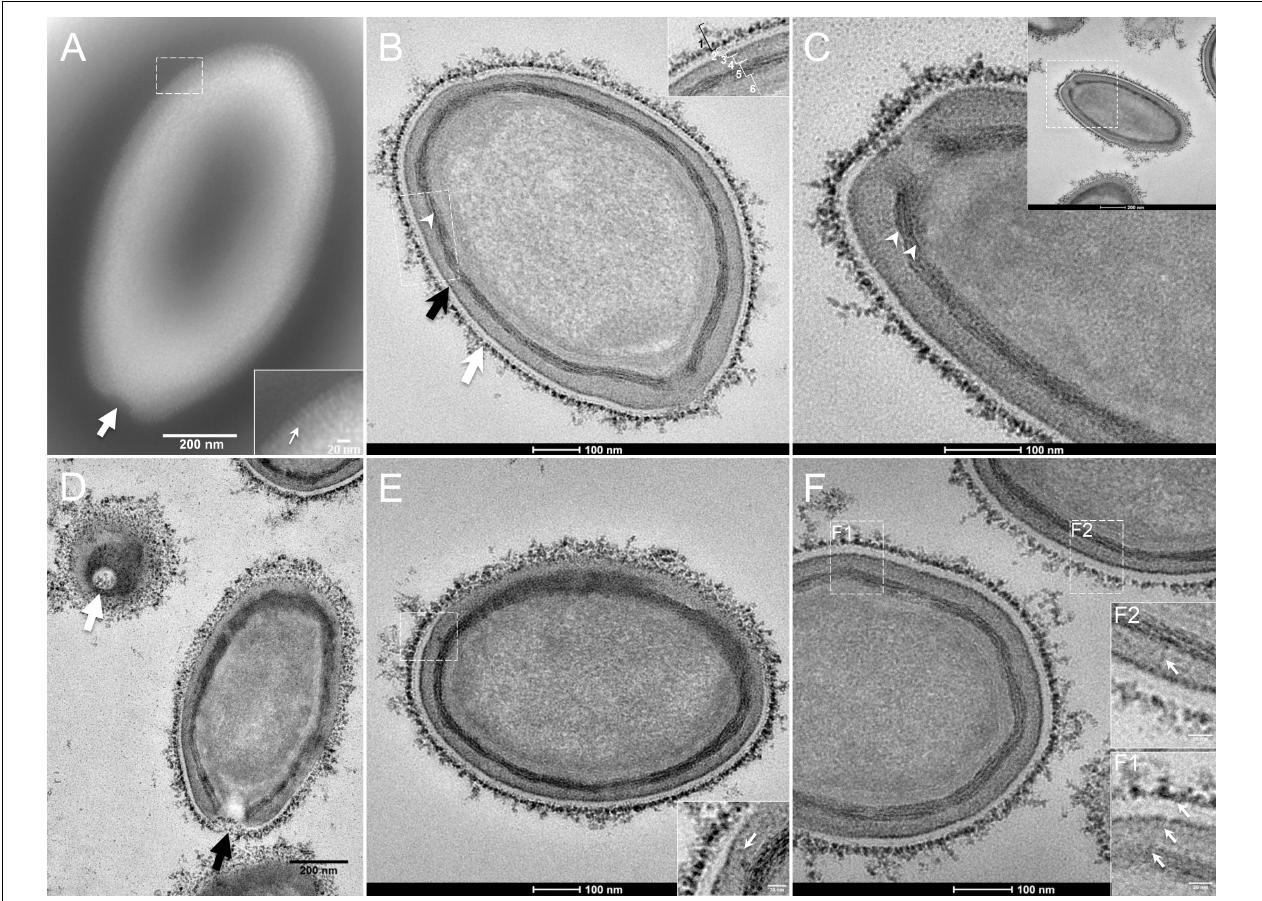
FIGURE 1 | Transmission electron microscopy (TEM) of Pandoravirus massiliensis . (A) Negative staining of a P. massiliensis particle: the ostiole (arrow) is located at the apex of the particle. Peripheral thin fibers can be observed enwrapping the particle (thin arrow in boxed zoomed region). (B) Ultrathin section showing (i) the most-peripheral sugars depicted by ruthenium red aggregates (thick white arrow and level 1 in boxed zoomed region); (ii) a thin electron-dense membrane (thick black arrow and level 3 in boxed zoomed region) and more centrally (iii) a thick bundle of tubules (thin white arrowhead and level 5 in boxed zoomed region). (C) Two thick tubules compose the inner-most thick layer (arrowheads). (D) Two particles with ostioles cut transversally or perpendicularly (white and black arrows). (E) The inner-most thick tubules with thick protrusions (white arrow in boxed zoomed region) toward the outer thin electron-dense membrane. (F) Thin fibers (white arrows in F1 and F2 boxed zoomed regions) projecting from the inner-most thick tubules, crossing the outer electron-dense membrane and reaching the peripheral ruthenium-red stained sugars.